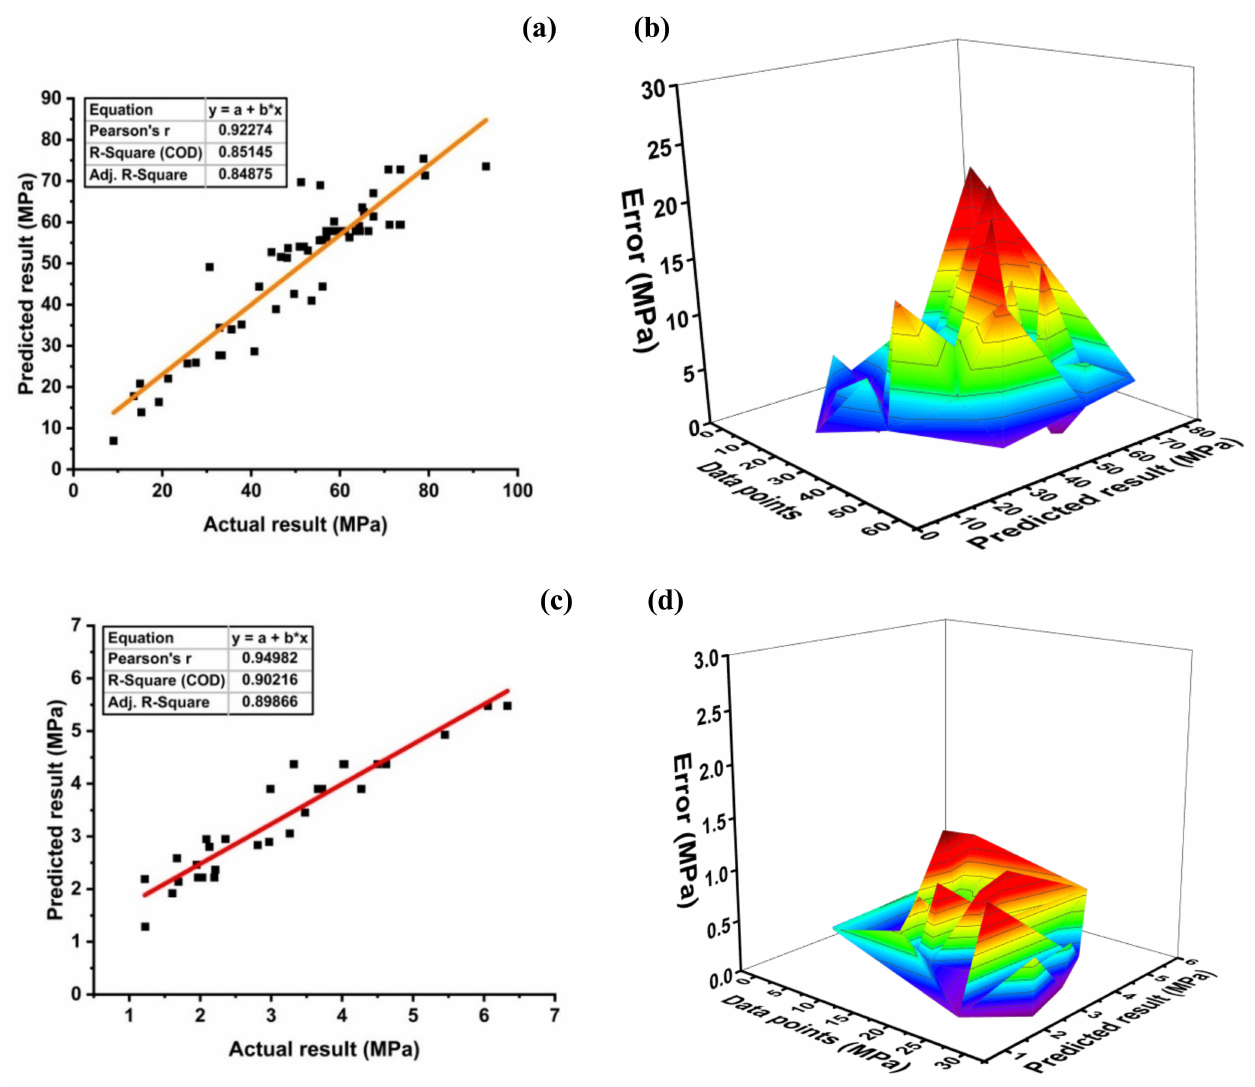
Figure 8. MLPNN model for; ( a ) compressive strength and ( b ) its error distribution between; ( c ) splitting tensile strength and ( d ) its error